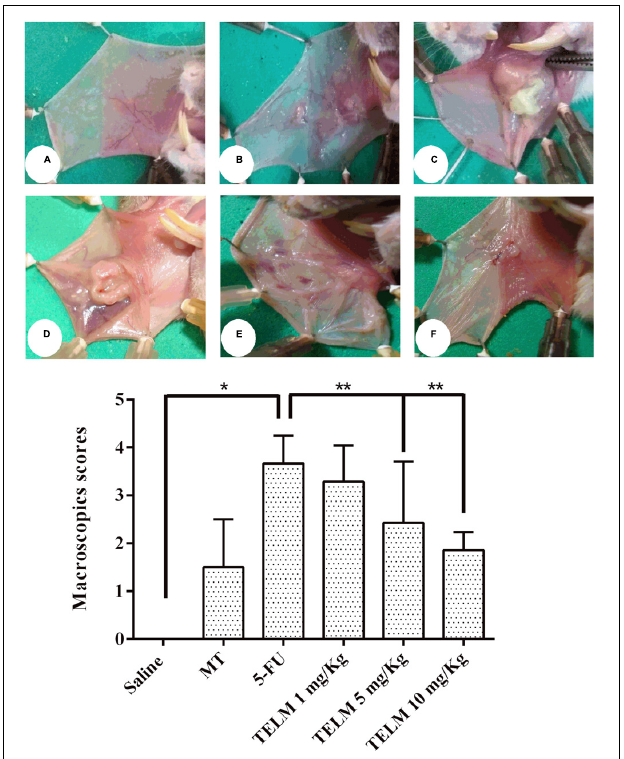
FIGURE 1 | Macroscopic analysis and scores of the oral mucosa of hamsters with oral mucositis (OM) induced by 5-fluorouracil (5-FU) and MT. The saline group consisted of animals with healthy oral mucosa (A) . The mechanical trauma (MT) group demonstrated vasodilation and erythema in the jugal mucosa (B) . The 5-FU group had changes in the oral mucosa, erythema, vasodilatation, erosion, and extensive ulcers (C) . TELM at 1 mg/kg did not improve the OM (D) . The groups treated with TELM 5 (E) , or 10 mg/kg (F) had mild vasodilation and superficial erosion in the oral mucosa, with no evidence of ulcers. The scores are represented with the standard error of the mean ( n = 5). ∗ p < 0.05 vs. the saline group, ∗∗ p < 0.05 vs. the 5-FU group (Kruskal–Wallis test and Dunn’s multiple comparison